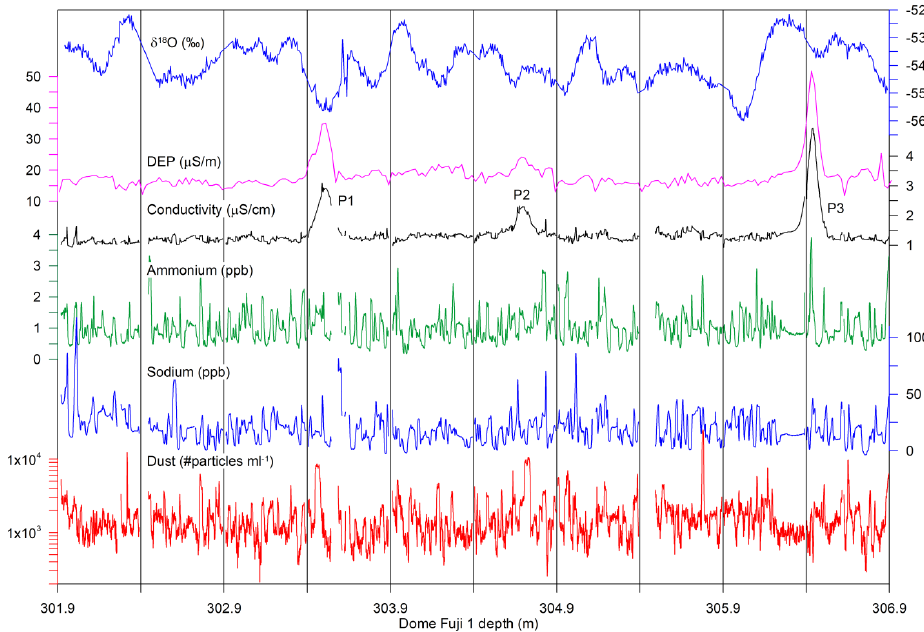
Figure 2. Overview of the high-resolution records obtained from the 5m of early Holocene Dome Fuji ice. From the top, the δ 18 O is obtained continuously on a cavity ring-down spectrometer and the dielectric profiling (DEP) is made on the solid ice. The electrolytic (liquid) conductivity, the ammonium, the sodium, and the dust concentrations were obtained on the Copenhagen CFA analytical system. Data gaps are due to core breaks or failure of the analytical systems. The three major acidity spikes P1, P2, and P3 centred at 303.51, 304.70, and 306.44m depth, respectively, are